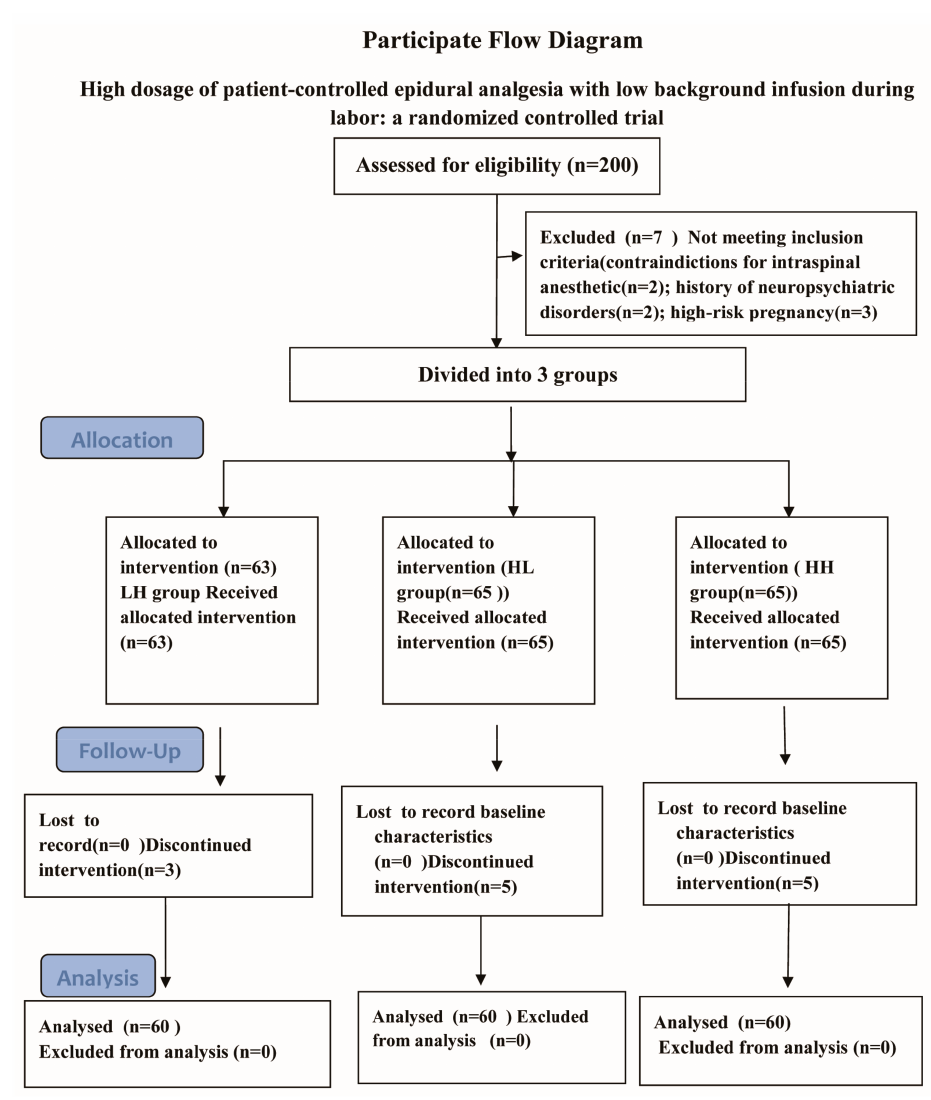
Figure 1. A total of 200 women met inclusion criteria for this study. These were randomized and 180 women received statistical analysis (Figure 1, flow diagram of study). Table 2. Comparison of VAS scores among the three